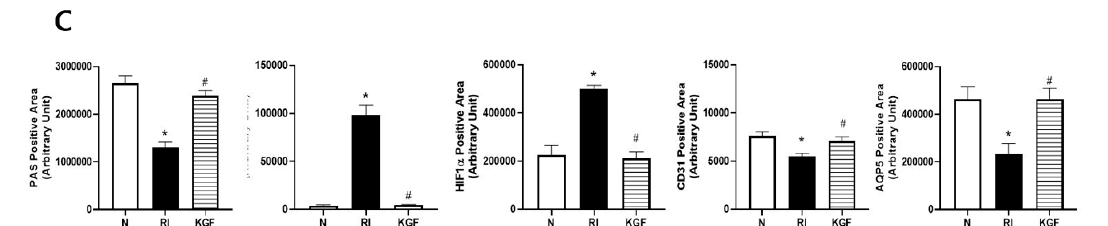
Figure 3. Histological analysis of salivary glands. ( A ) Representative histological images of PAS and MT staining. ( B ) Representative immunohistochemical images showing HIF1a, salivary epithelial cells (AQP5 stained) and endothelial cells (CD31 stained). ( C ) More mucin-containing acini and less periductal fibrosis were observed in the RI + KGF-1 group than in the RI group. The expression of HIF1a was higher and the expressions of AQP5 and CD31 were lower in the RI group than in treatment naïve controls. HIF1a staining intensities was lesser, and AQP5 and CD31 staining intensities were greater in the RI + KGF-1 group than in the RI group. (N; treatment naïve control group, RI; RI group, KGF; RI + KGF-1 group). Results are presented as means ± SDs; *, vs. treatment naïve controls; # , vs. the RI group. * p < 0.05, # p < 0.05 ( n = 6 mice per group) (N; treatment naïve controls, RI; RI group, KGF; RI + KGF-1 group), Scale bar: 50 µ m.